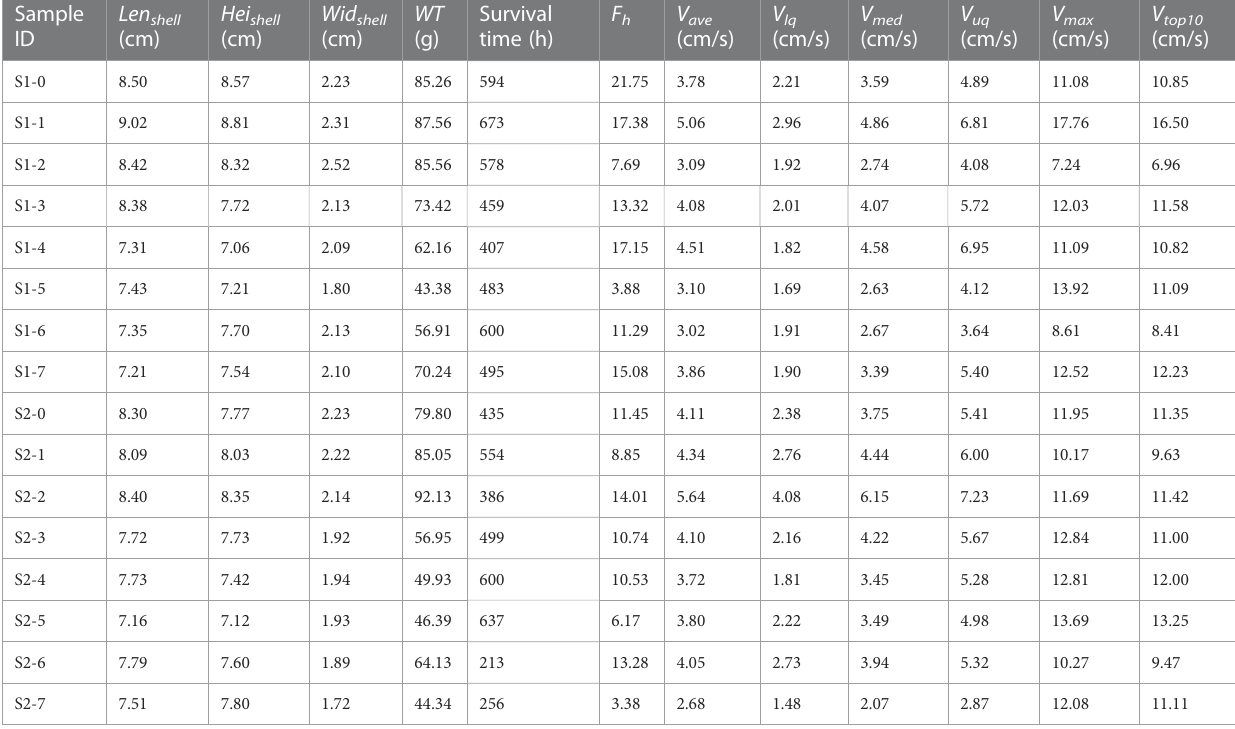
TABLE 1 Statistics of valve movements in scallops ( Patinopecten yessoensis ). Sample